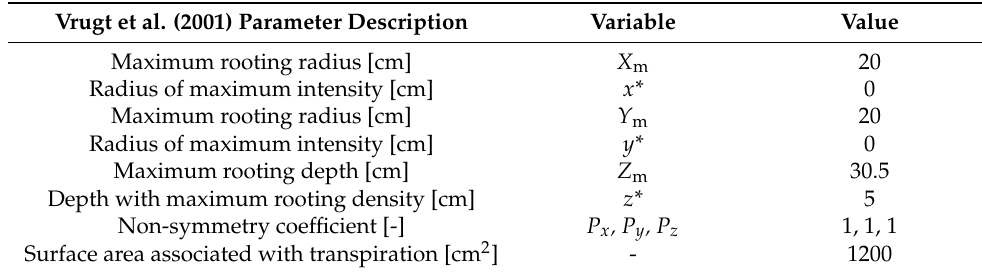
Table 2. The Vrugt et al. [32] parameters for strawberries